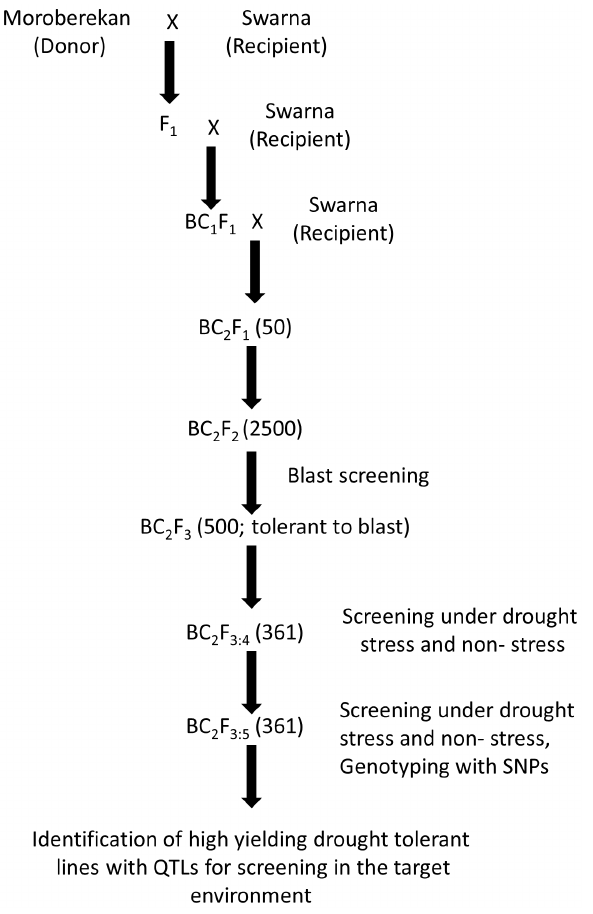
Figure 1. Population development and phenotypic screening strategy used to develop a blast-tolerant BC 2 F 3 -derived mapping population for mapping QTLs for high grain yield under drought stress and non-stress